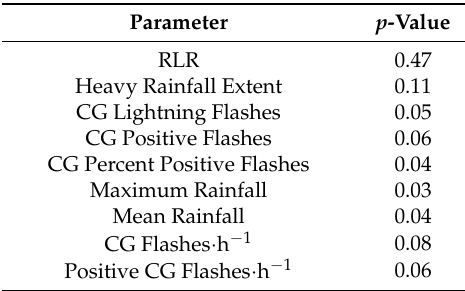
Table 1. p -Values determined by nonparametric Mann–Whitney test for elevated thunderstorms vs. surface based thunderstorms.